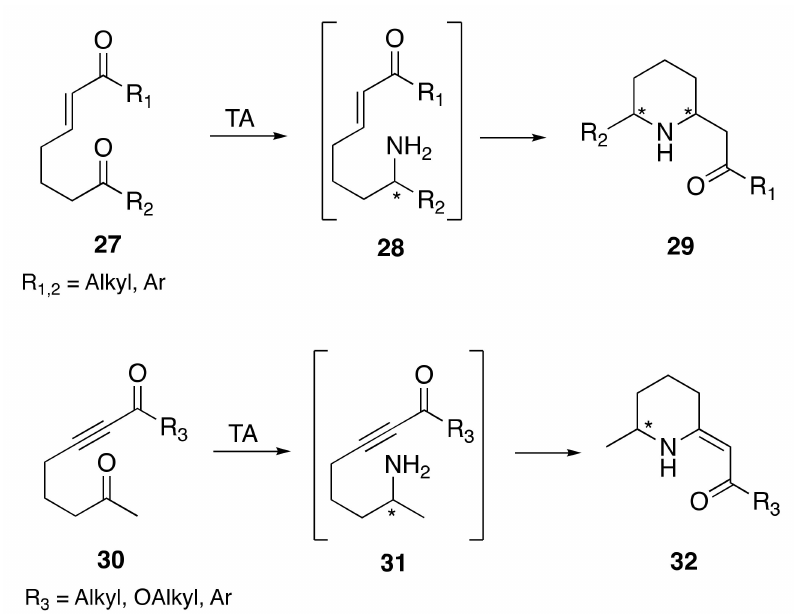
Figure 6. Tandem TA/intramolecular aza-Michael reaction for 2,6-disubstituted piperidines.